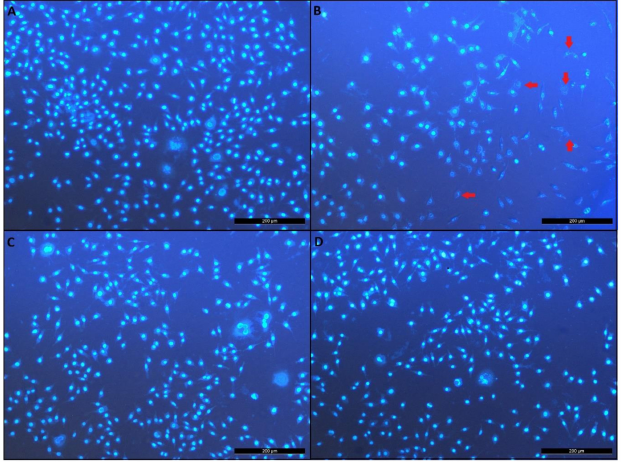
Figure 6. Effects of GPE and GPE3 on apoptosis and necrosis in cellular model of AD (Hoechst 33258) (n = 5), ( A ) Untreated group, ( B ) A β 1-42 (20 µ M), ( C ) GPE3 (50 µ M) + A β 1-42 , ( D ) GPE (50 µ M) + A β 1-42 . biomolecules 2020 , 17 , x. https://doi.org/10.3390/biomleculesxxxxx 15 of 21 Red arrows indicate necrotic cells with damaged chromosomal structures.